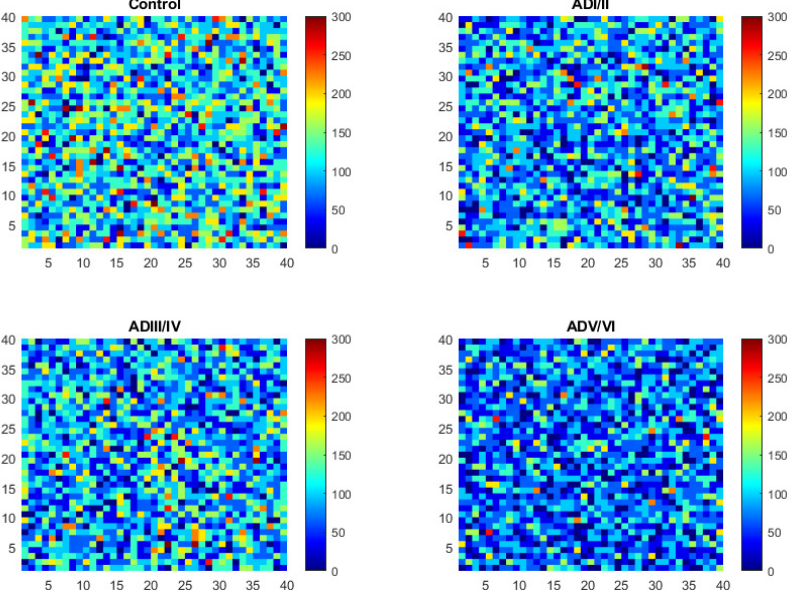
Figure 5. Snapshots of peroxidability index (PI) maps, calculated using formula from [33], in the four neuropathological stages shown in Figure 1. Simulations were obtained after 1000 iterations. Peroxidability index was calculated in 5 × 5 patches from simulations in Figure 1. Color scales represent PI ranges.